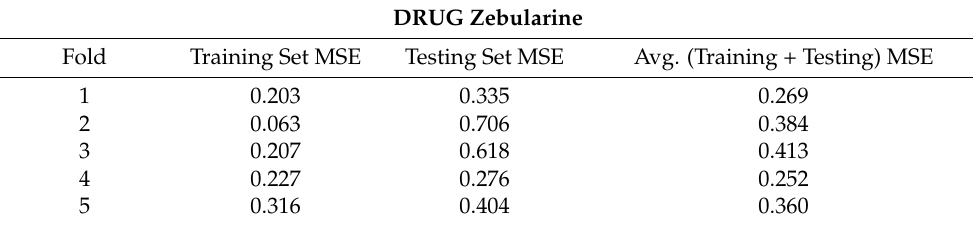
Table 7. 5-fold cross-validation results for kESVR model ( k = 8) of drug zebularine.